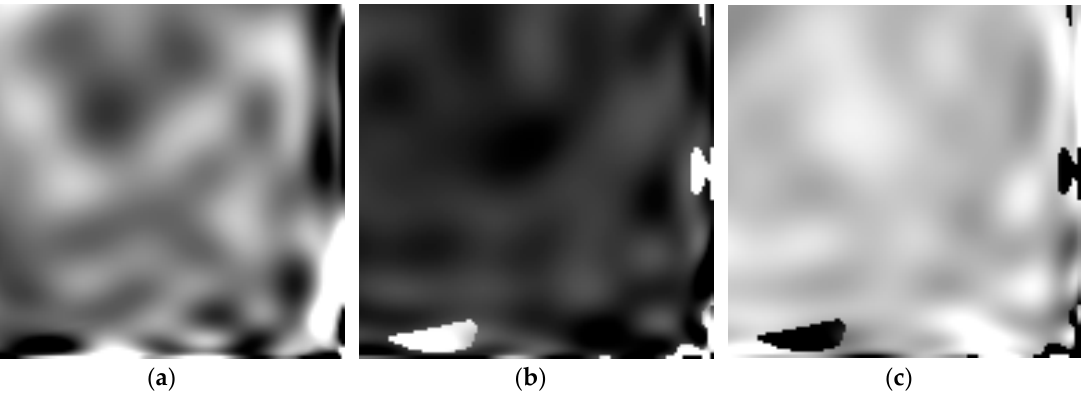
Figure 12. Abundance maps. ( a ) Water; ( b ) Oil; ( c ) Cloud.